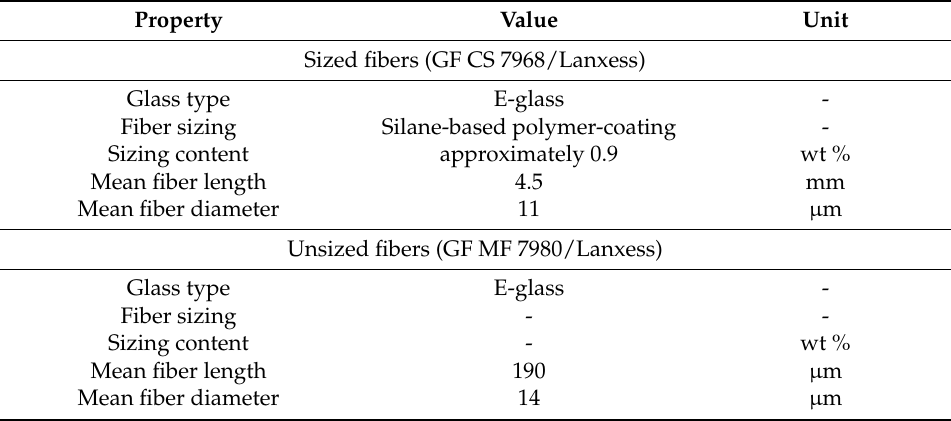
Table 4. Material properties of the investigated glass fibers (unsized [31]/sized